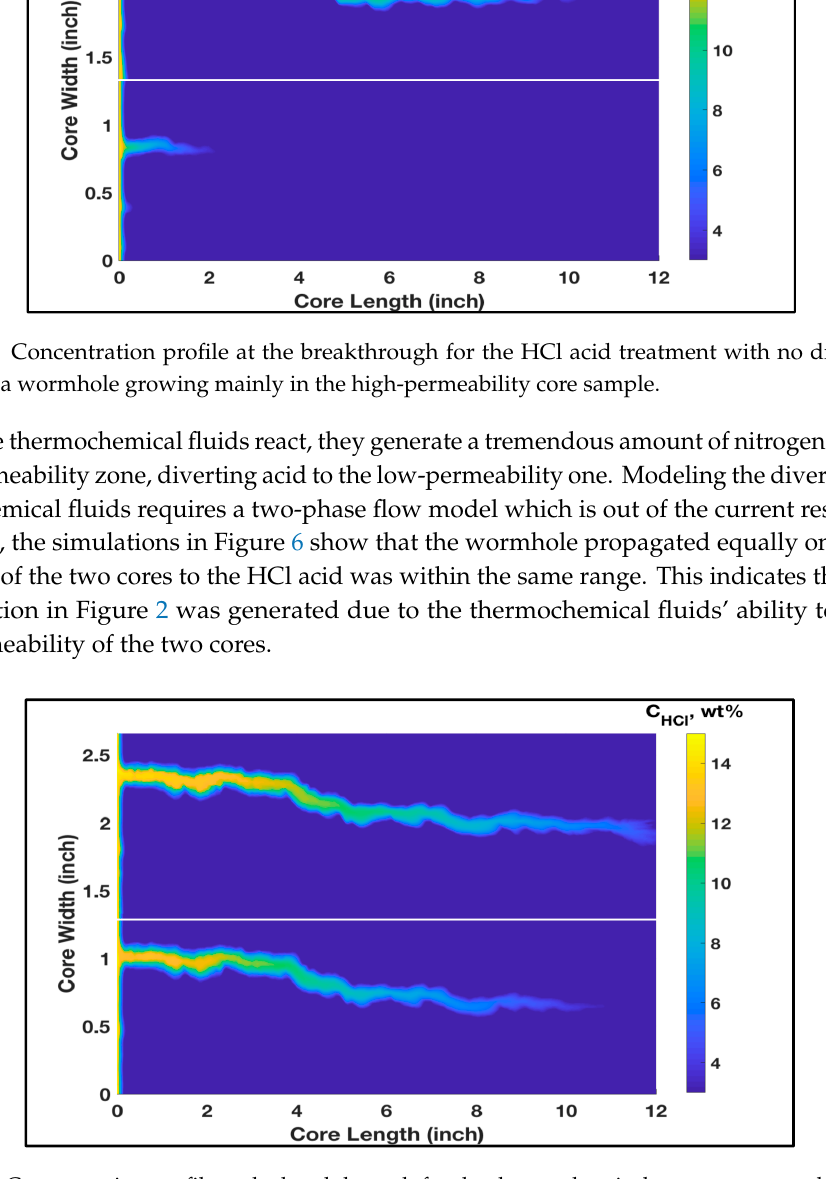
Figure 6. Concentration profile at the breakthrough for the thermochemical treatment case, showing a wormhole growing almost